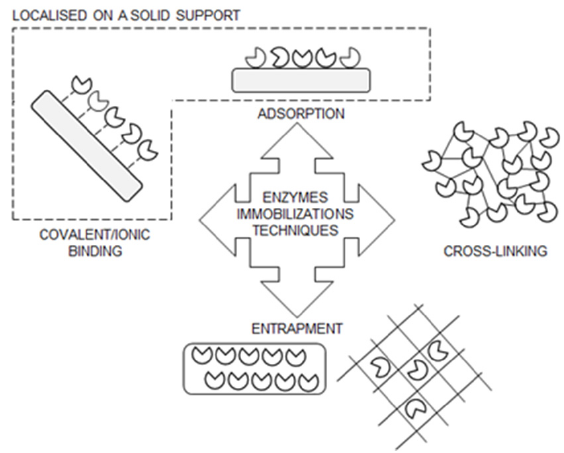
Figure 2. Overview of techniques for the immobilization of enzymes (modified according to Ref. [45], with permission from publisher Josip Juraj Strossmayer of Osijek, Faculty of Food Technology Osijek, 2019).